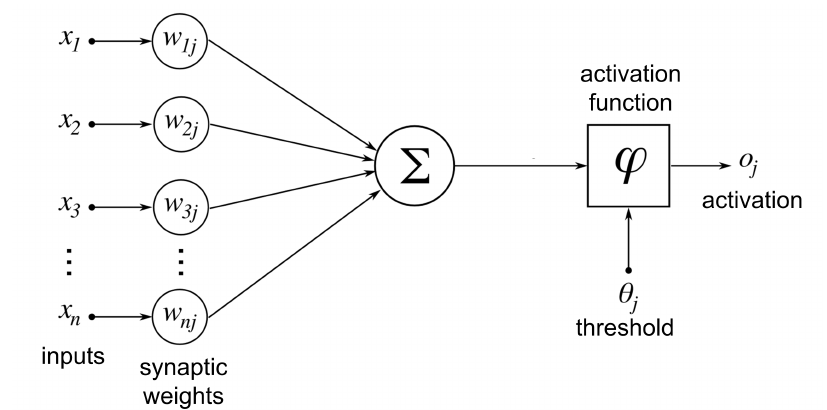
Figure 1. Diagram of an artificial neuron with n inputs with their corresponding synaptic weights. All weighted inputs are added and an activation function controls the generation of the output